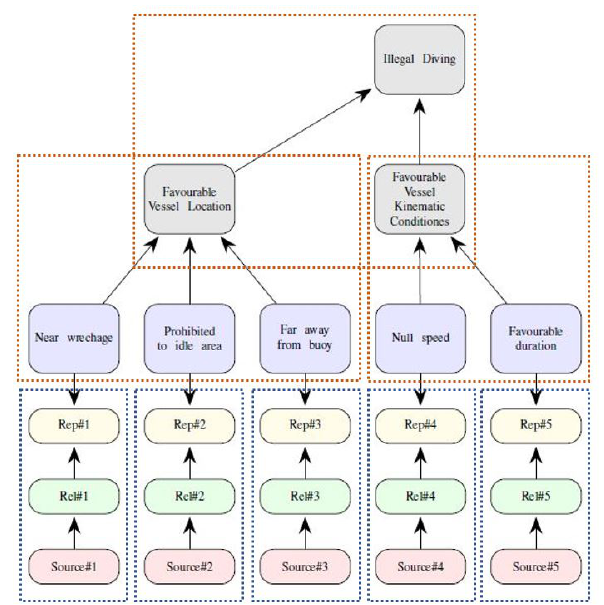
Figure 3. Portion of the multi-source Bayesian network (adapted from [35]) and its division in knowledge structures.